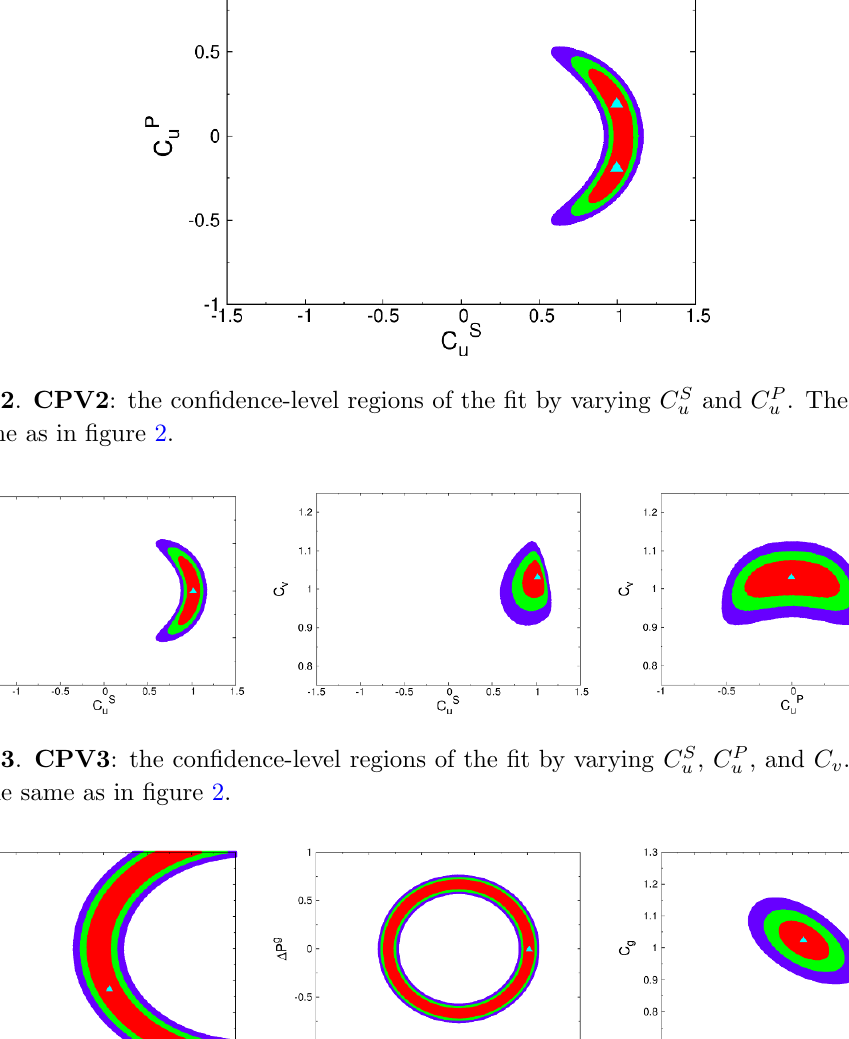
Figure 14 . CPV4 : the con(cid:12)dence-level regions of the (cid:12)t by varying (cid:1) S (cid:13) , (cid:1) S g , (cid:1) P (cid:13) , and (cid:1) P g . The color code is the same as in (cid:12)gure